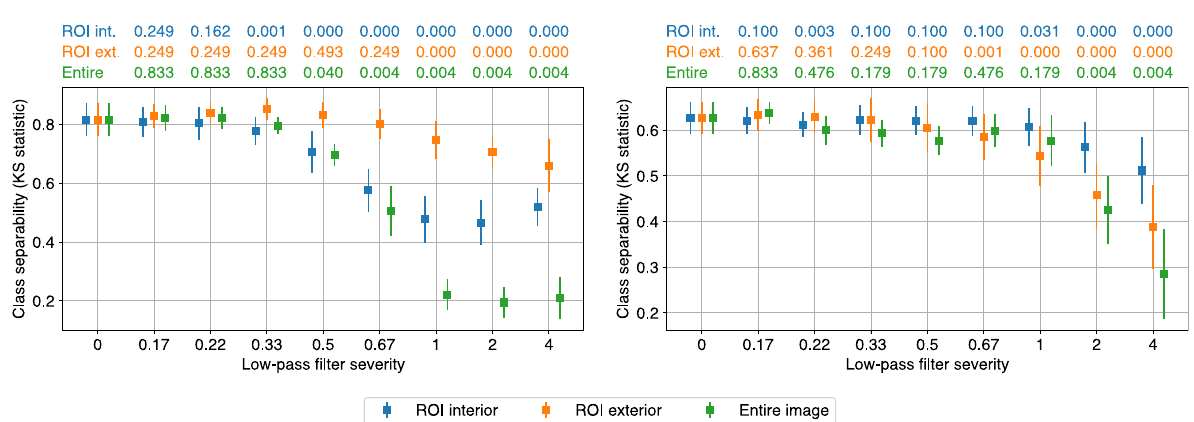
Figure 5. Comparing humans and machines with respect to the regions of an image deemed most suspicious. The performance of DNNs trained on unfiltered images was evaluated on images with selective perturbations in regions of interest (ROIs) identified as suspicious by human radiologists. (a) For microcalcifications, filtering the ROI interior decreases predictive confidence, but not as much as filtering the entire image. Filtering the ROI exterior decreases predictive confidence as well, meaning that DNNs utilize high frequency components in both the interior and the exterior of the ROIs, whereas humans focus more selectively on those ROIs. (b) For soft tissue lesions, filtering the ROI interior has very little effect on class separability. Meanwhile, filtering the ROI exterior has a similar effect to filtering the entire image. This implies that the high frequency components used by DNNs in these lesion subgroups are not localized in the areas that radiologists consider suspicious. Figure created with drawio v13.9.0 https:// github. com/ jgraph/ biases possessed by DNNs, such as their tendency to look at texture over shape 36 . Such differences must be better understood and reconciled in order to establish trust in machine-based diagnosis.